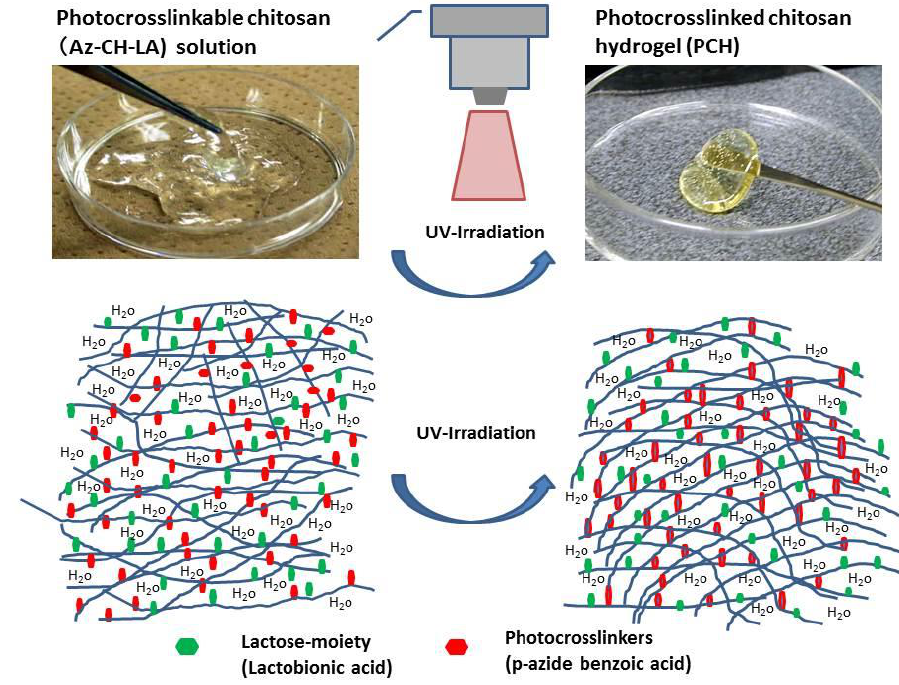
Figure 1. Photocrosslinkable chitosan (Az-CH-LA) solution and photocrosslinked chitosan hydrogel (PCH). The viscous Az-CH-LA solution ( upper, left photograph ) was converted to insoluble soft rubber-like PCH ( upper, right photograph ) through crosslinking reaction of the azide and amino groups of Az-CH-LA with UV-irradiation ( lower illustration ).